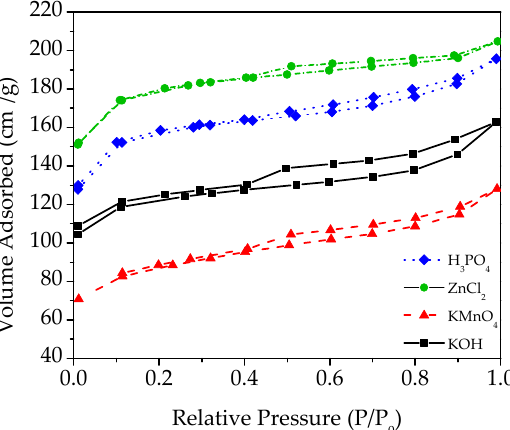
Figure 1. Effect on chemical activating agent on the adsorption-desorption isotherms of activated carbon from sago